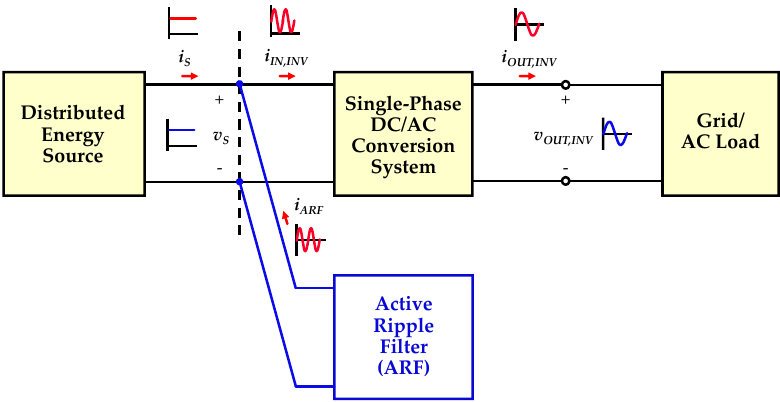
Figure 2. Integration of the ARF into a single-phase DC/AC conversion system [26].